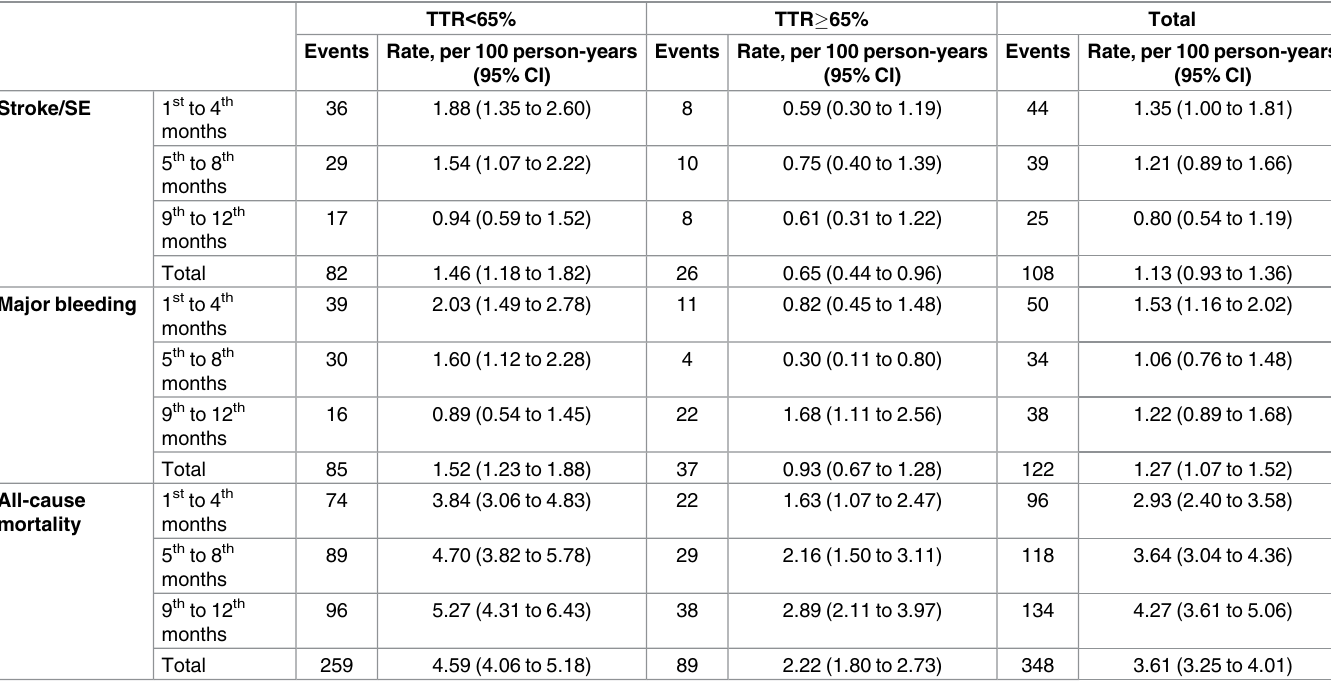
Table 6. Four-month event rates in patients with proportion of time in therapeutic range < 65% and (cid:21) 65%.